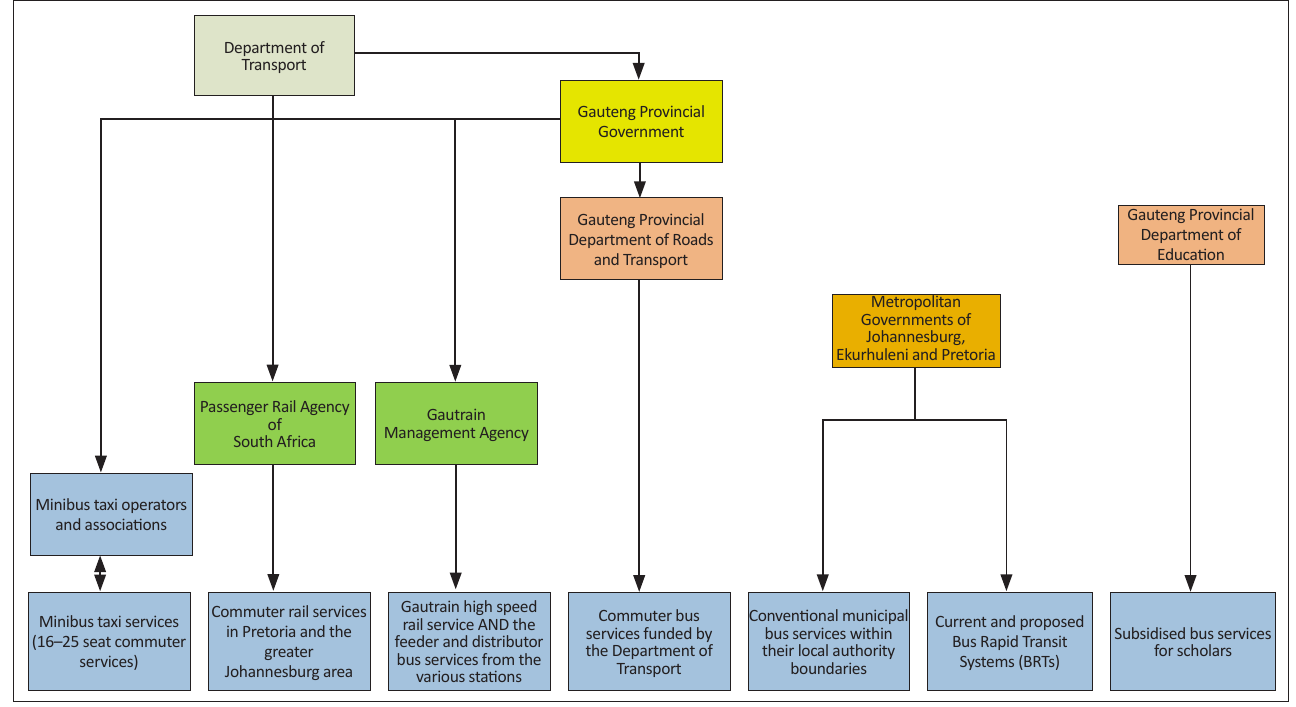
FIGURE 1: An example of fragmented public transport planning in